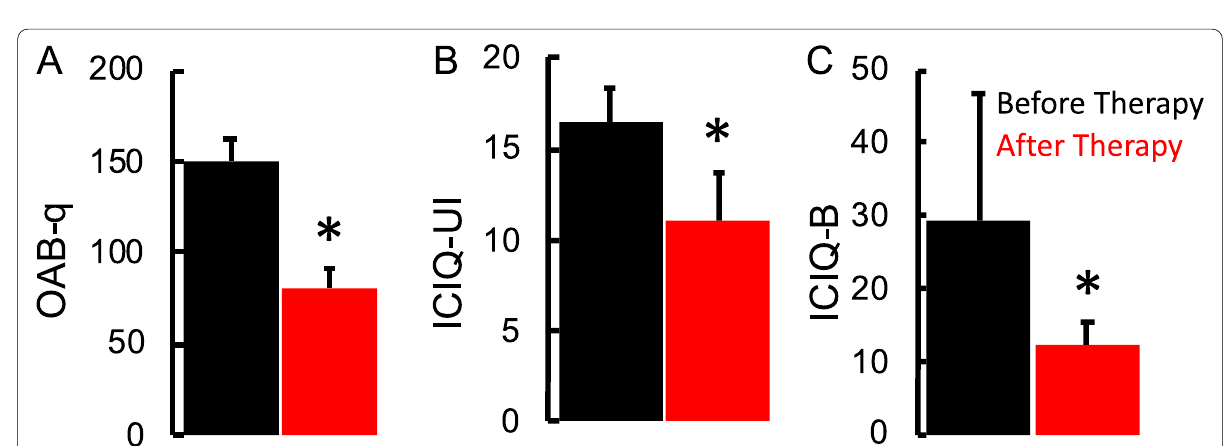
Fig. 3 Survey scores. A Mean